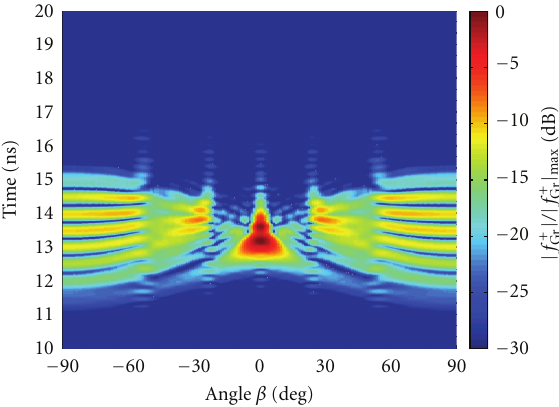
Figure 15: Impulse response of synthesised antenna